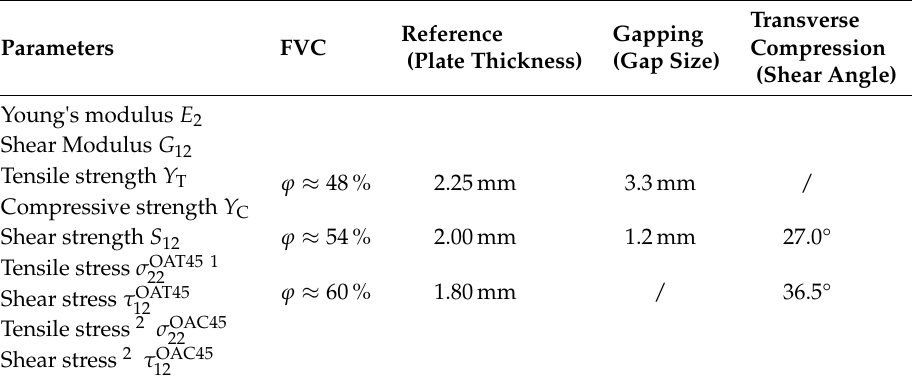
Table 2. Design of experiments in transverse fiber direction.